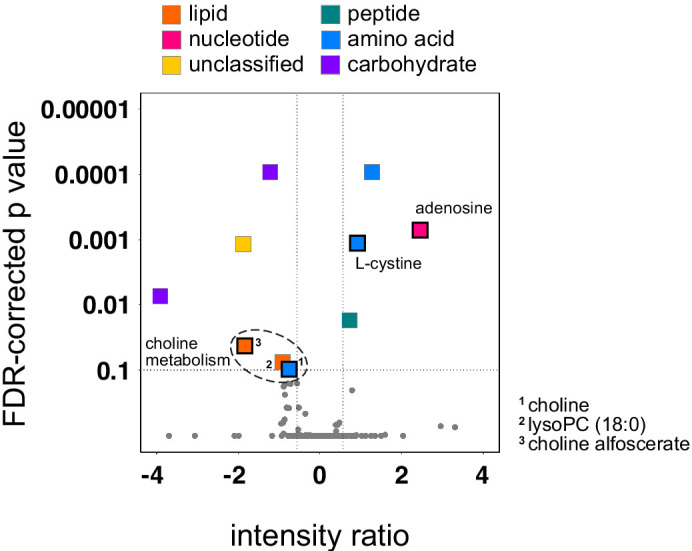
A conserved early metabolic signature of falciparum malaria.Volcano plot showing the 10 plasma metabolites that were differentially abundant during infection. We grouped unresponsive (v018 and v208), inflammatory (v016, v017 and v013), and suppressor (v022 and v019) hosts and grouped two post-infection time-points (day 8 and diagnosis) to identify a conserved and persistent signature, respectively. These samples (n = 14) were tested against pre-infection plasma (n = 7) using an FDR-corrected p value < 0.1. A positive intensity ratio indicates metabolites are more abundant during infection, whereas a negative ratio indicates metabolite depletion. Vertical black dotted lines represent a 1.5-fold change in abundance. Squares with a solid black border show that an authentic standard was run in tandem with the samples to validate metabolite detection.